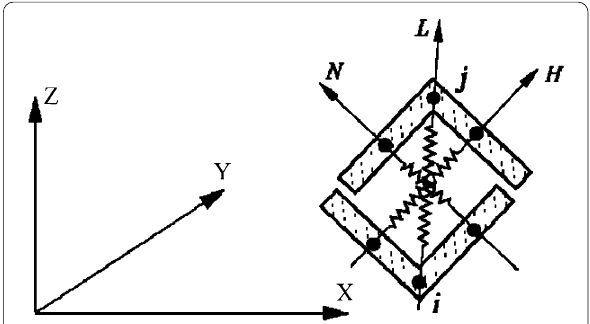
Fig.13 Direction setting diagram of Spring elements COMBIN39 of the adhesive [52]